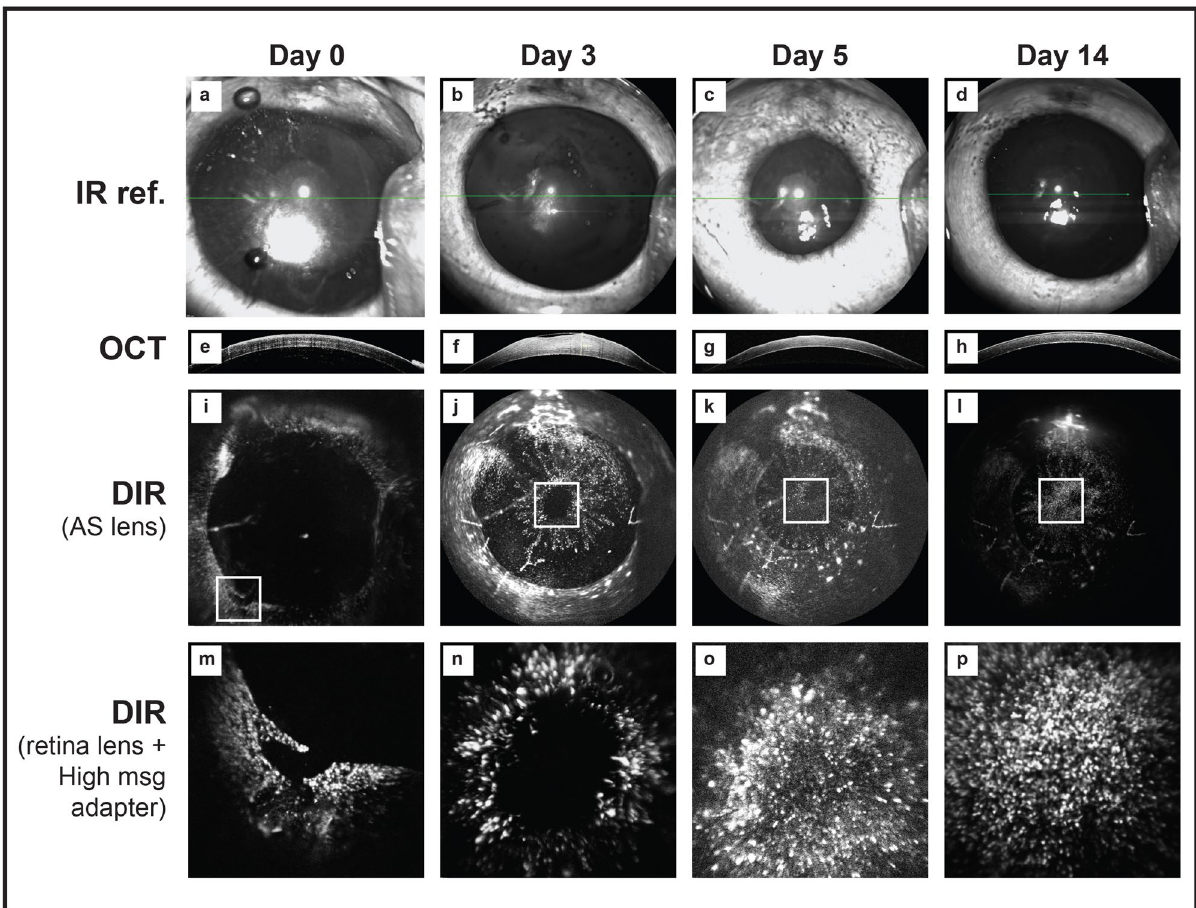
Figure 7. In vivo tracking of endothelial cells at pan-corneal and single-cell level. Images taken from an individual, DIR stained rabbit cornea. Following standard endothelial wounding, infra-red ( a – d ), OCT ( e – h ) and DIR images ( i – p ) were acquired using the HRA/Spectralis. Use of the anterior segment lens supplied by the manufacturer allowed macroscopic imaging of the whole cornea. By coupling additional lenses to the infinity optics retinal lens, higher magnification imaged could be captured ( m – p ). The images in the bottom row correspond to the areas seen in the white square outline in the macroscopic images. By sequentially imaging with increasing magnification, it was possible to track areas of interest. Immediately after scraping no DIR positive cells are seen in the wound area ( i , m ). At day 3 the cornea is still significant thicker that pre- wounding ( f ). The wound area can be seen to be much smaller ( j , white box). At higher magnification levels, migrating cells closing the wound at the edge are seen ( n ). By day 5, although some residual corneal oedema and thickening persists on OCT imaging ( g ), complete wound closure can be observed ( k , o ). By day 14, corneal thickness has returned to normal ( h ) and a stable layer of DIR positive cells was observed with macroscopic ( i ) and higher magnification imaging ( p